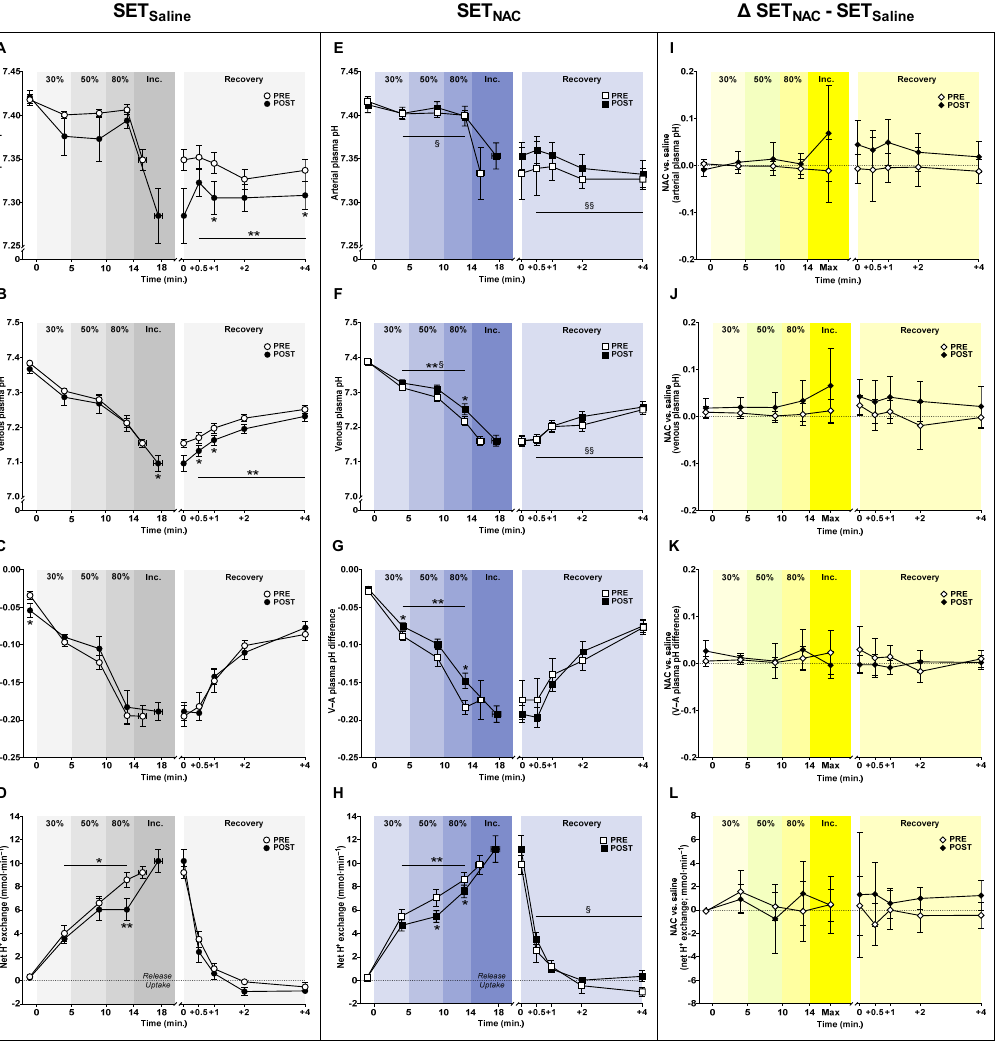
Figure 5. Effect of speed endurance training (SET) on plasma pH and H + shifts without and with N -acetylcysteine infusion. Plasma pH ( A – C , E – G ) and net leg H + exchange ( D , H ) before, during, and after knee-extensor exercise without (SET Saline , n = 10) and with N -acetylcysteine (SET NAC , n = 9) in- fusion as well as differences ( Δ ) between SET NAC and SET Saline ( I – L , n = 9) before (pre) and after (post) SET. ** Post different from pre ( p < 0.01). * Post different from pre ( p < 0.05). §§ Trial × leg effect ( p < 0.01). § Trial × leg effect ( p < 0.05). Data are presented as mean ± SEM (SET Saline and SET NAC ) or mean ± 95% CI ( Δ SET NAC − SET Saline ).